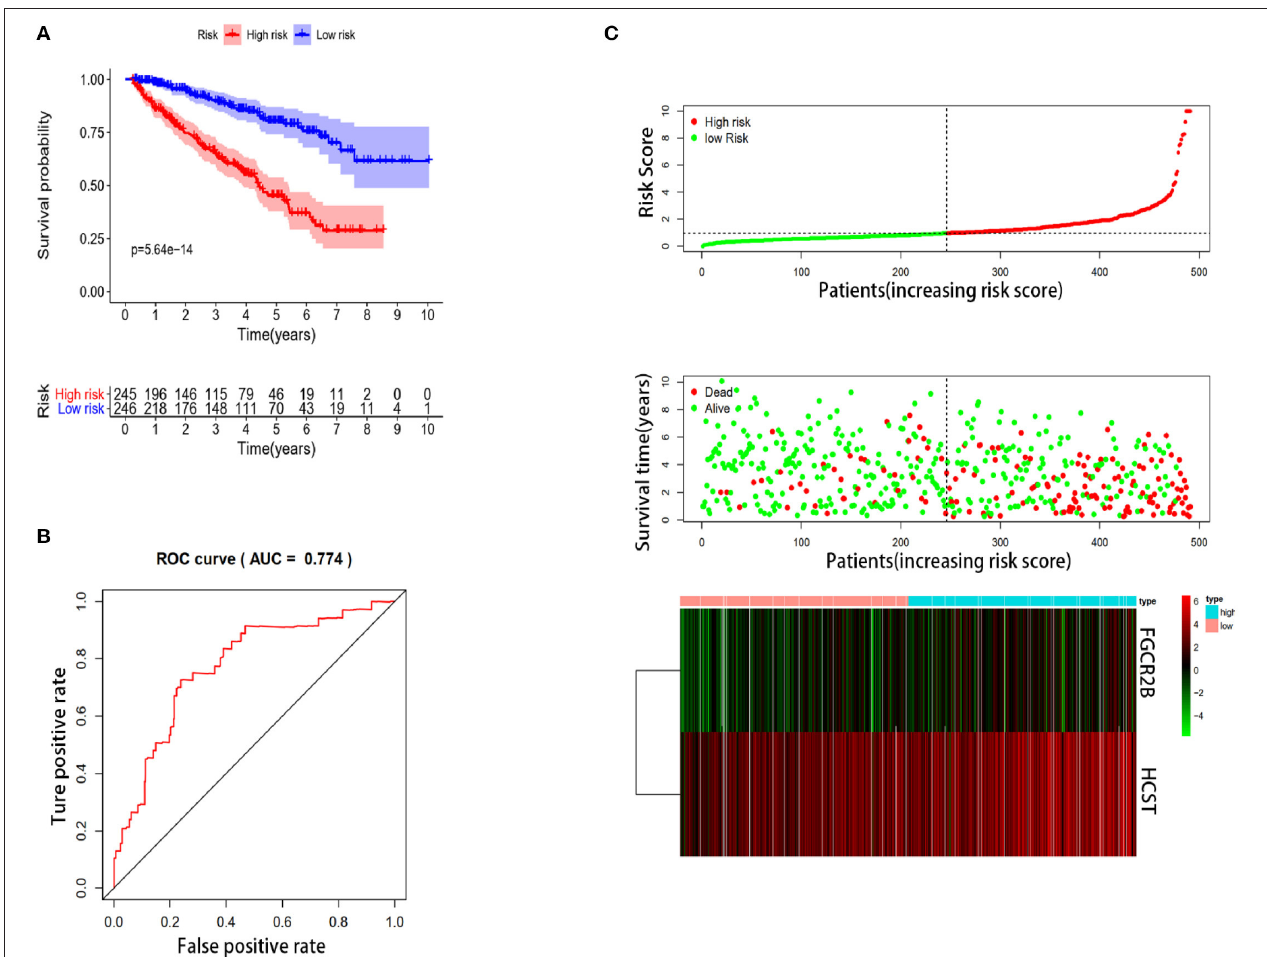
FIGURE 3 | Construction of the immune-system-based risk signature by means of the training set. (A) Patients in the high-risk group had shorter OS. (B) A receiver-operating characteristic curve illustrating the prognostic value of the risk signature. (C) Ranking of the risk signature and distribution of the risk groups, survival status of the patients in the low-risk and high-risk groups, and a heatmap of expression profiles of the included genes.